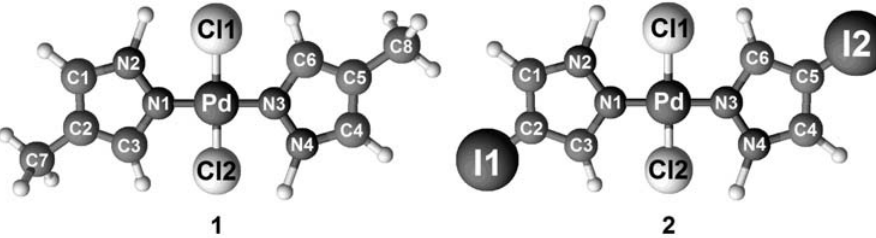
] ( 1 ) and [ PdCl (HmPz) 2 2